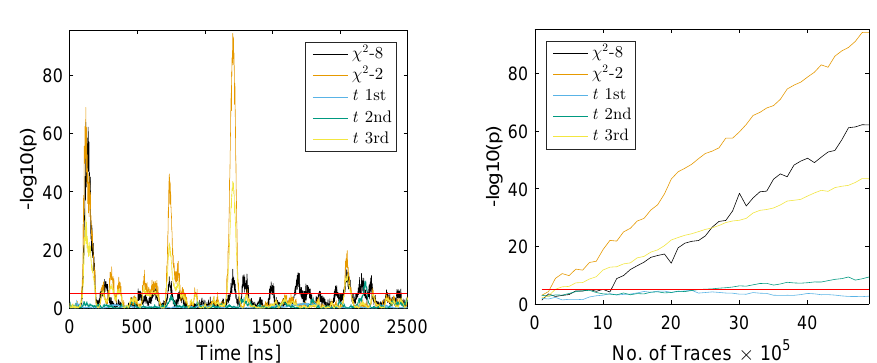
Figure 9: Comparison between 8- and 2-fixed plaintext χ 2 -test and 1st- to 3rd-order t -tests for the best combinations of two fixed